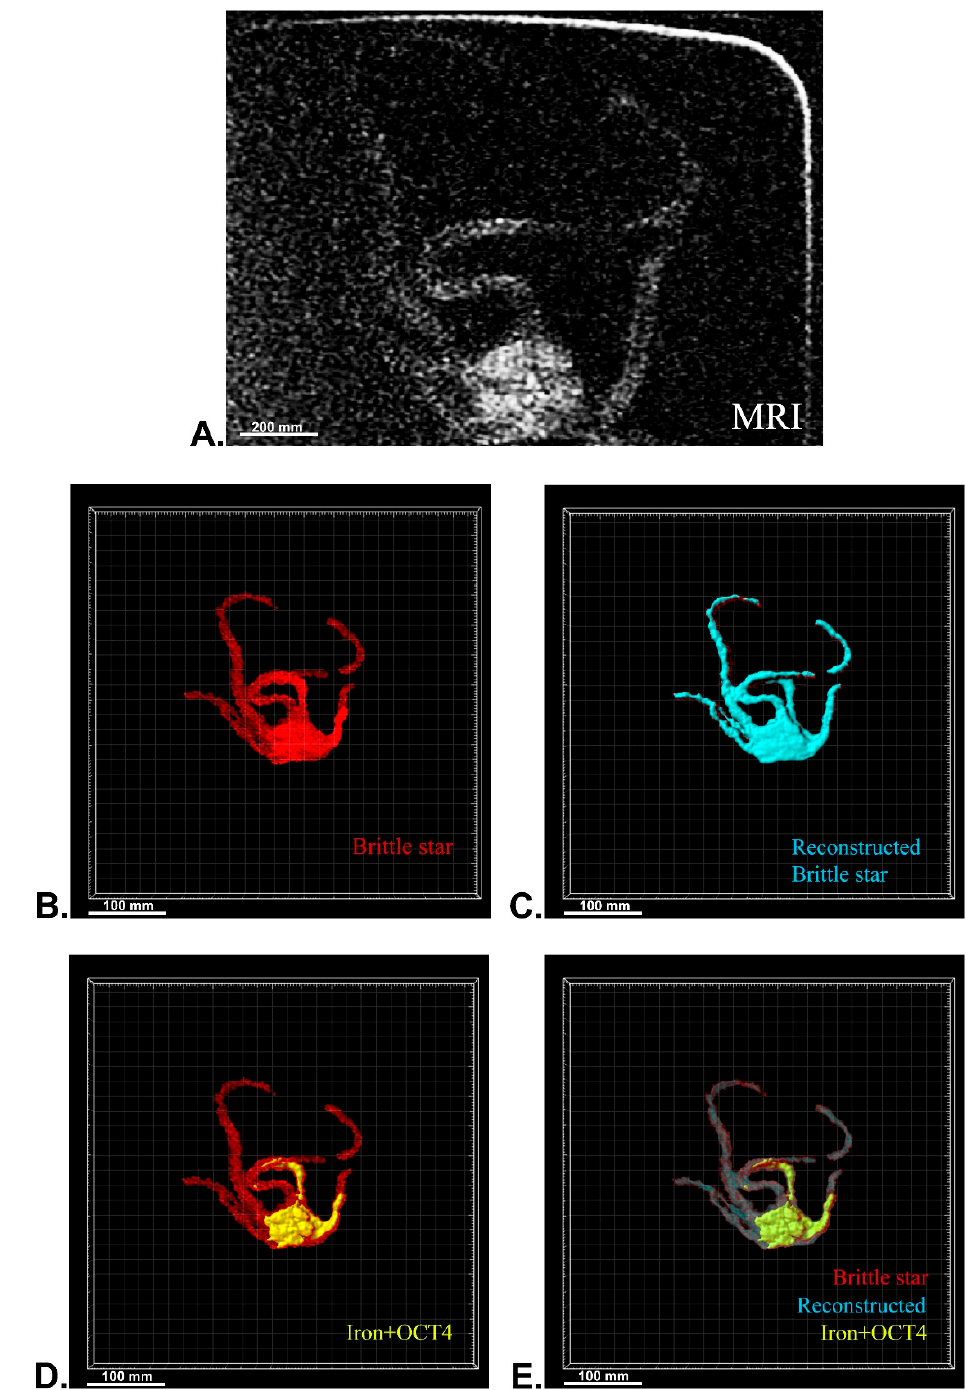
Figure 8. Three-dimensional (3D) reconstruction of brittle star tissue with iron plus anti-Oct4 antibody treatment using magnetic resonance imaging (MRI) serial images: ( A ) original grayscale image; ( B ) whole tissue imaging and signals of the brittle star tissue without reconstruction; ( C ) brittle star whole tissue 3D reconstruction in which the blue surface represents reconstructed brittle star tissue; ( D ) 3D reconstruction of the iron plus anti-Oct4 antibody signals (shown in yellow); ( E ) 3D reconstruction of the whole tissue of brittle star with its all signals. All scale bars in four images are 100 mm. All images were processed and generated by Imaris software (V 7.4.2, ImarisX64; Bitplane AG).